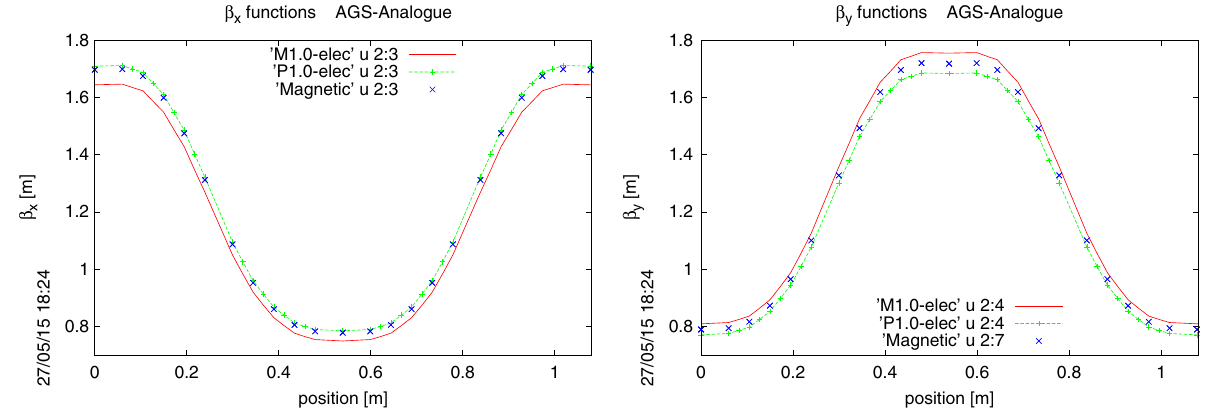
FIG. 4. Comparison for AGS_Analogue2.sxf lattice with bends treated as electric m ¼ 1 (indicated by P1.0 ) or m ¼ − 1 (indicated by M1.0 ) or magnetic. β x is plotted on the left, β y on the right. As explained in the text, because of the strong focusing in the AGS analog lattice, switching from magnetic to electric bending causes only minor changes to the lattice